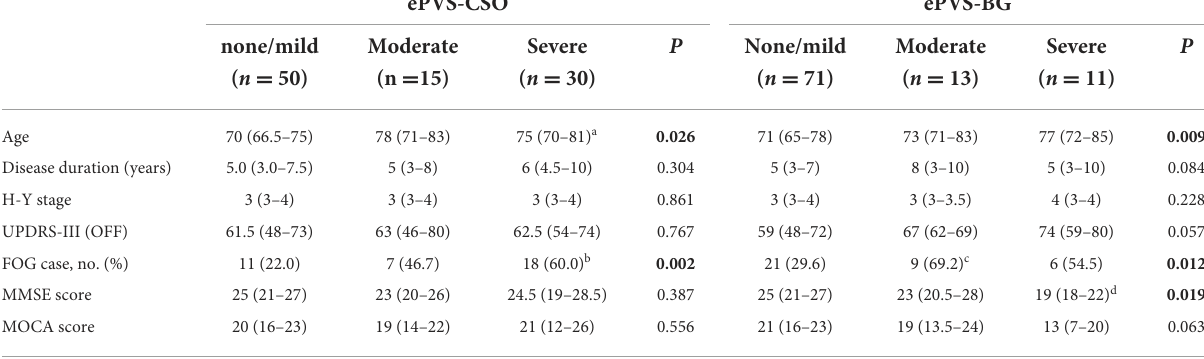
TABLE 3 Clinical characteristics of patients with PD according to the severity and location of enlarged